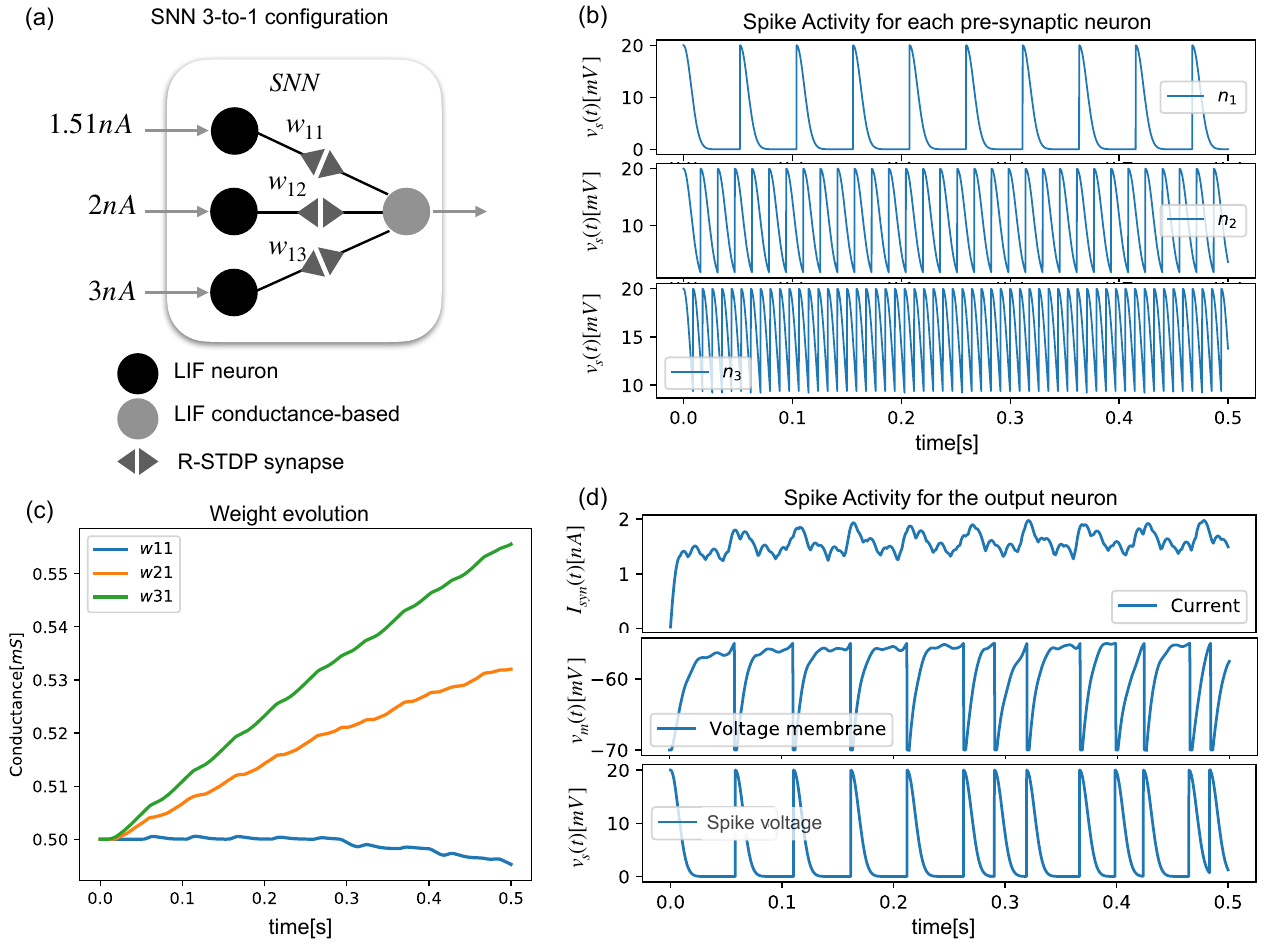
Figure 2. ( a ) An SNN with three LIF neurons in the input layer and one output layer. ( b ) Spiking activity of the first layer. ( c ) Evolution of the weight of the synapse. ( d ) Neural activity (input current, membrane voltage, and spike voltage) of the output